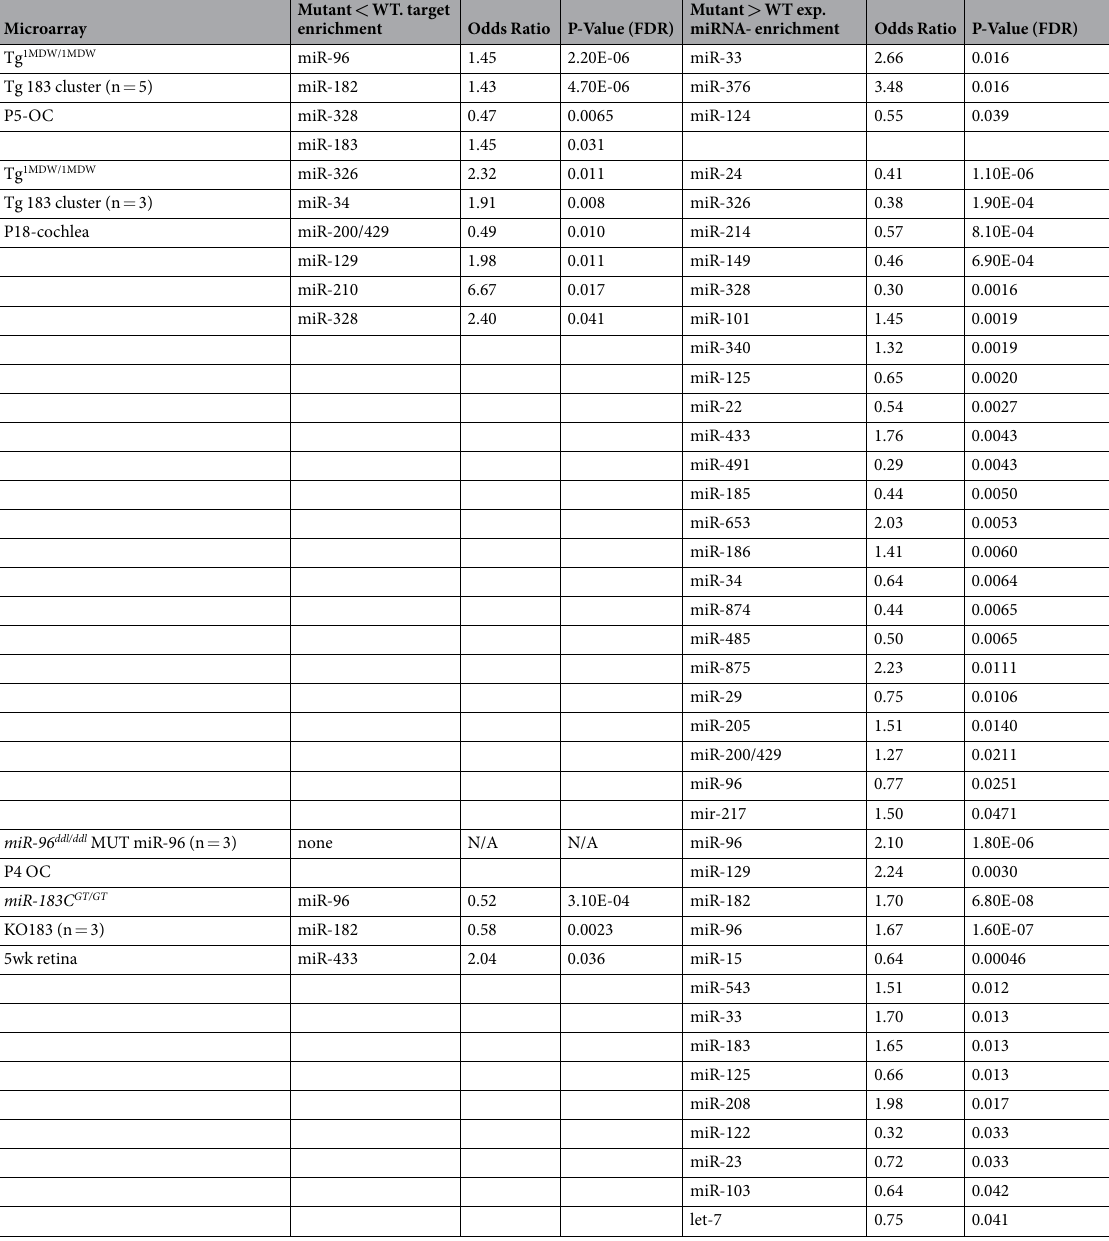
Table 5. Hypergeometric analysis of genome-wide microarray data demonstrate miR-183 cluster specific enrichment/depletion of evolutionary miRNA/3 ′ UTR seed